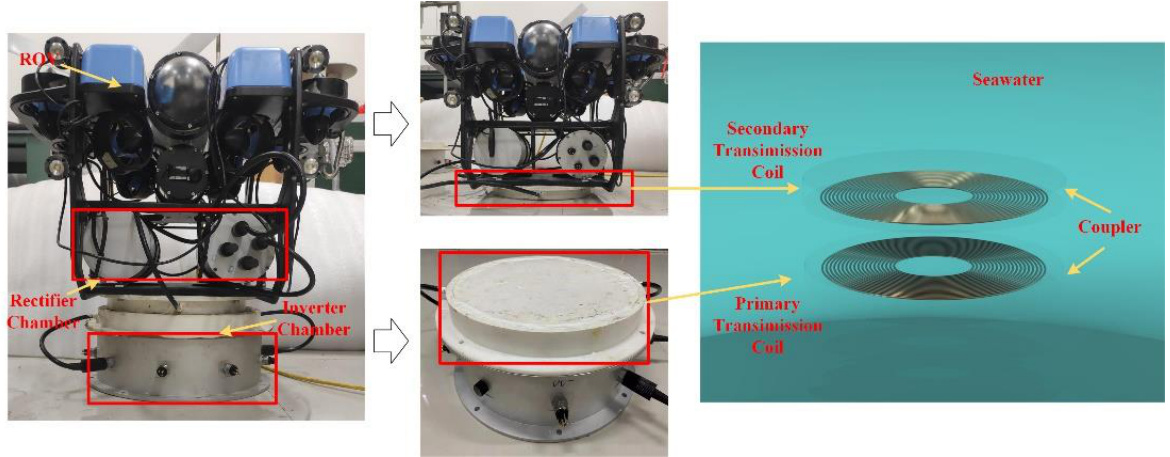
Figure 1. Schematic diagram of WPT system and planar dual-coil model.